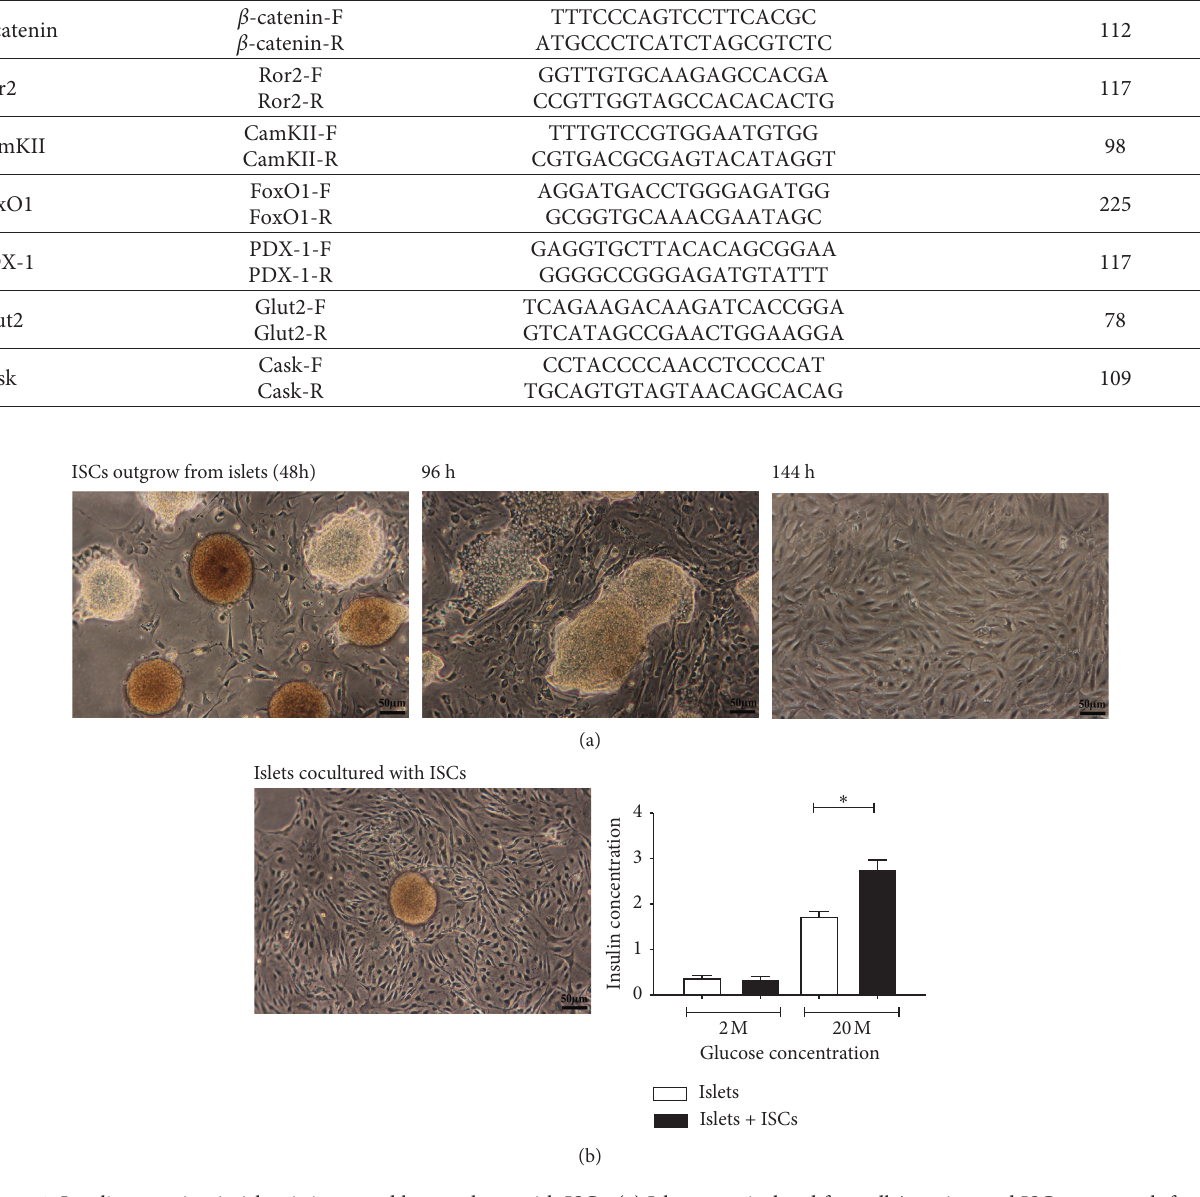
Figure 1: Insulin secretion in islets is increased by coculture with ISCs. (a) Islets were isolated from db/m mice, and ISCs outgrowth from the islets was analysed by microscopy (scale bars � 50 μ m). (b) Compared with islets cultured alone, islets cocultured with ISCs isolated from db/m mice showed significantly increased insulin secretion in vitro. The data are expressed as the mean ± SE ( n � 3), ∗ p < 0 . 05, ∗∗ p < 0 . 01, vs. islets cultured alone.